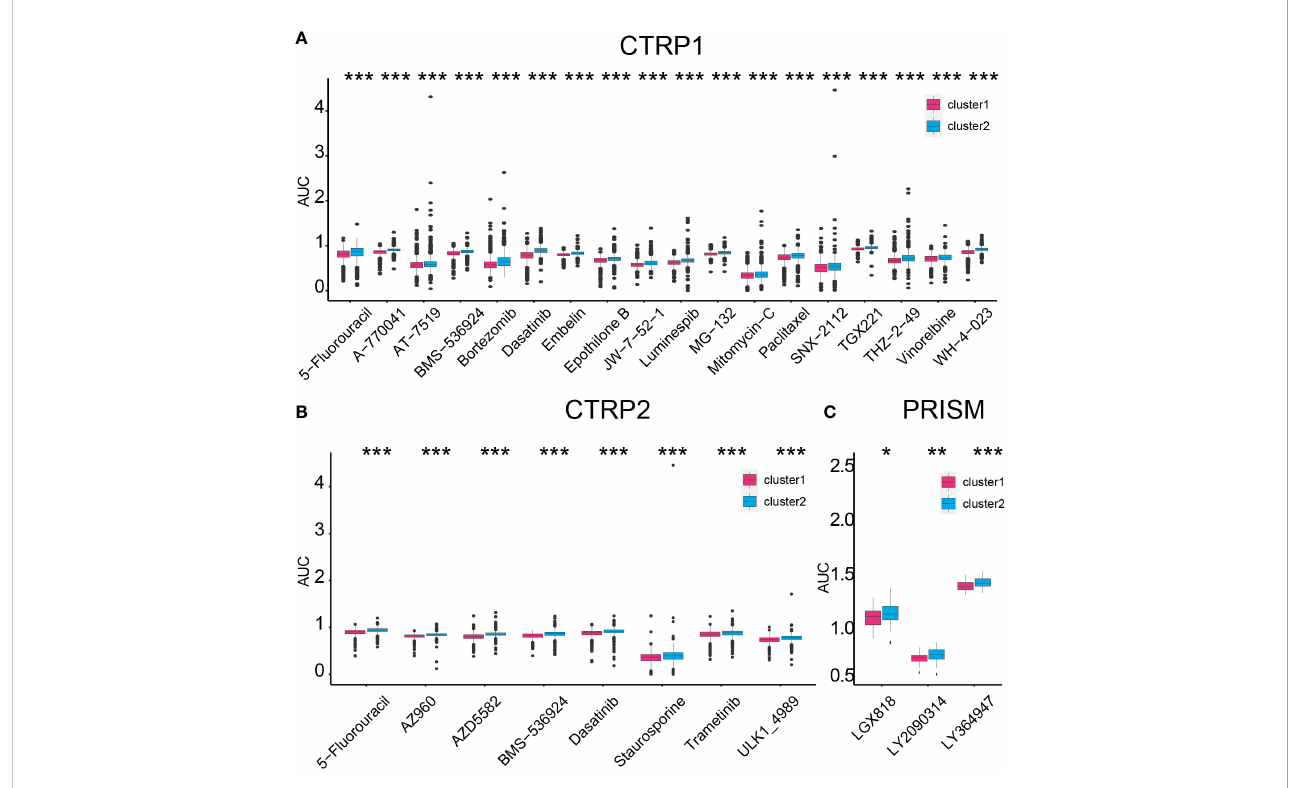
FIGURE 9 Compound prediction based on the cluster model. Cluster 1 sample sensitive compounds from CTRP1 (A) , CTRP2 (B) , and PRISM (C) databases. *P < 0.05, **P < 0.01, ***P <